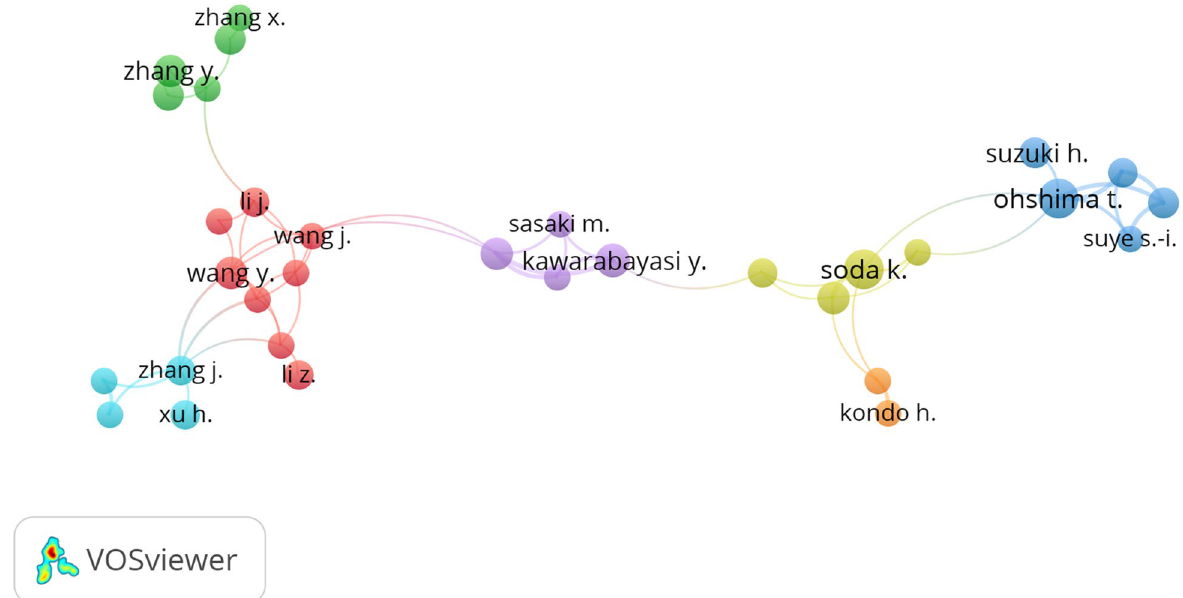
Fig. 6 The top 30 most productive authors collaborate in thermostable lipase research according to a bibliometric analysis of the Scopus